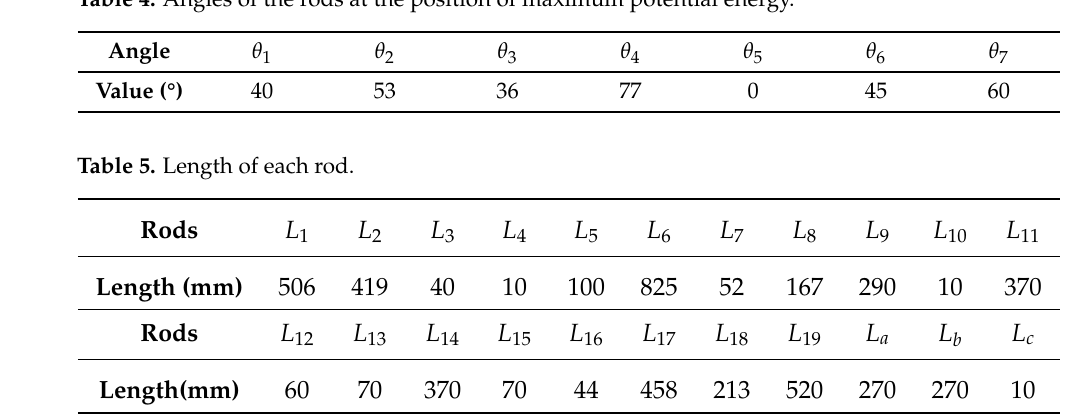
Table 4. Angles of the rods at the position of maximum potential energy.